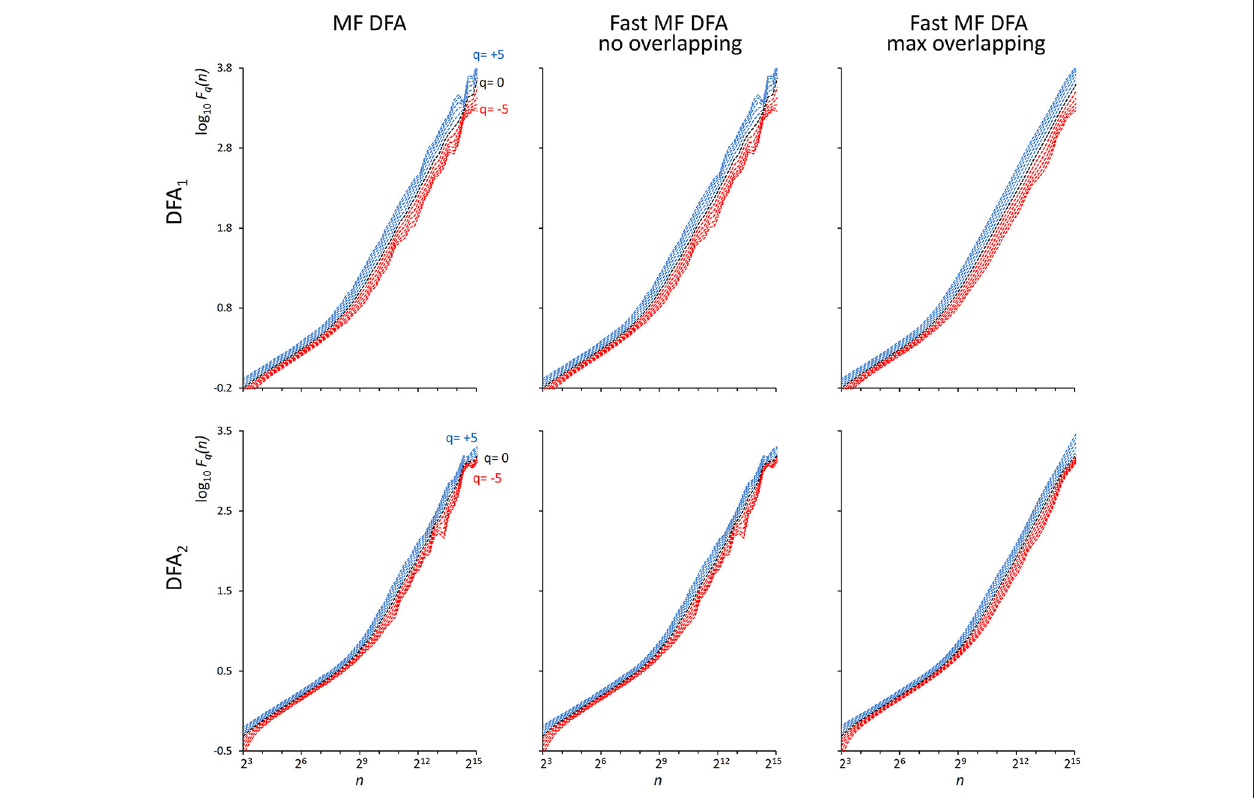
FIGURE 2 | F q (n) functions by the traditional (MF DFA) and the proposed fast algorithm (Fast MF DFA) for the {wb i } series. The series of N = 200,000 samples is the superposition of white noise and Brownian motion (see text); estimates without overlapping by the traditional algorithm (Left) and by our fast algorithm (Center) and with maximum overlapping by our fast algorithm (Right) were performed over 56 block sizes exponentially distributed over the n axis, with thresholds Th 1 and Th 2 as in Equations (19) and EPS = 0. On a laptop computer, the traditional algorithm employed T = 57s for calculating DFA 1 and T = 146s for calculating DFA 2 without overlapping, the fast algorithm employed 2.2s without overlapping and 65s with maximum overlapping for calculating both the DFA 1 and DFA 2 estimates simultaneously.